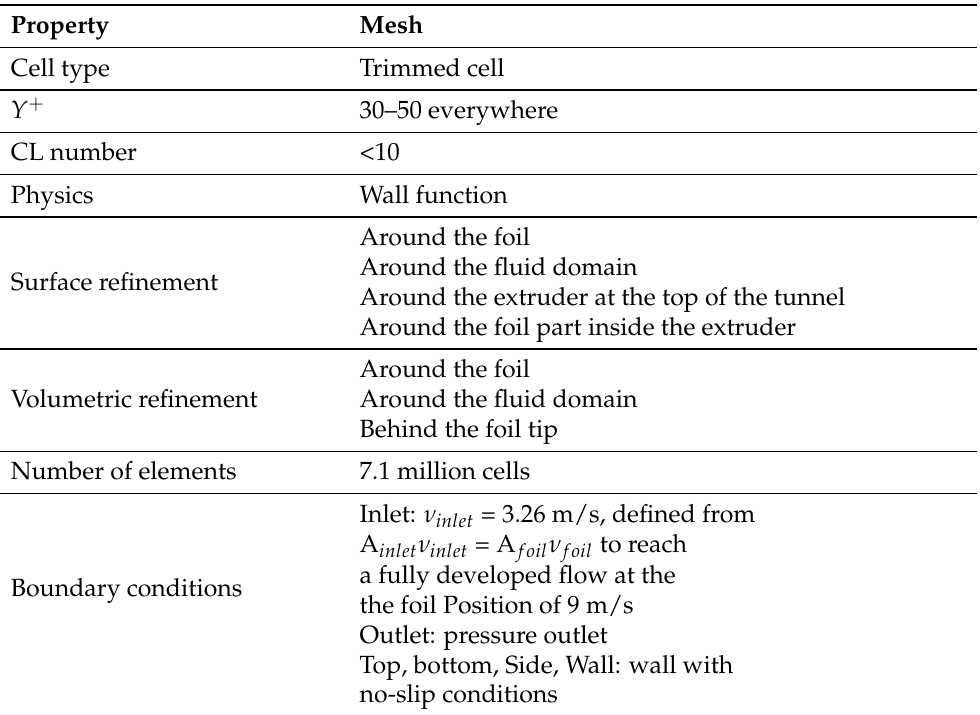
Table 5. Numerical settings.